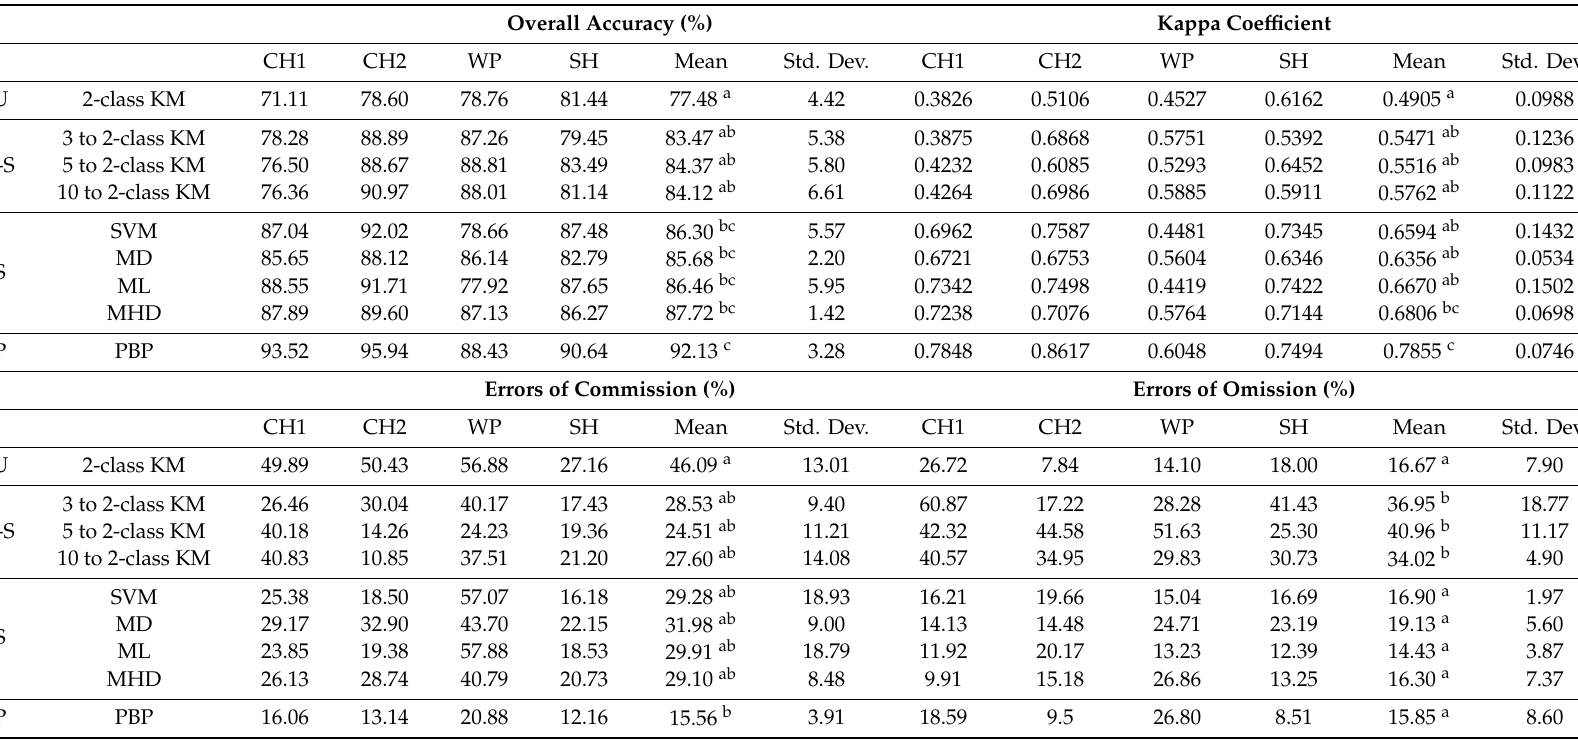
Table 3. The accuracy comparison between unsupervised, combined-unsupervised, supervised classifications, and proposed automatic regional